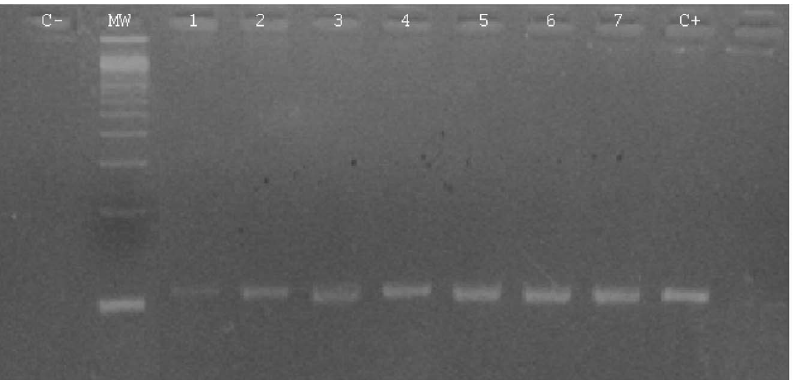
Figure 1. Electrophoretic pattern of the direct PCR on sheep hearts. C- corresponds to negative control of PCR; MW: 100bp ladder; 1–9: amplification of different sheep isolates and C + corresponds to the positive control of the reaction.